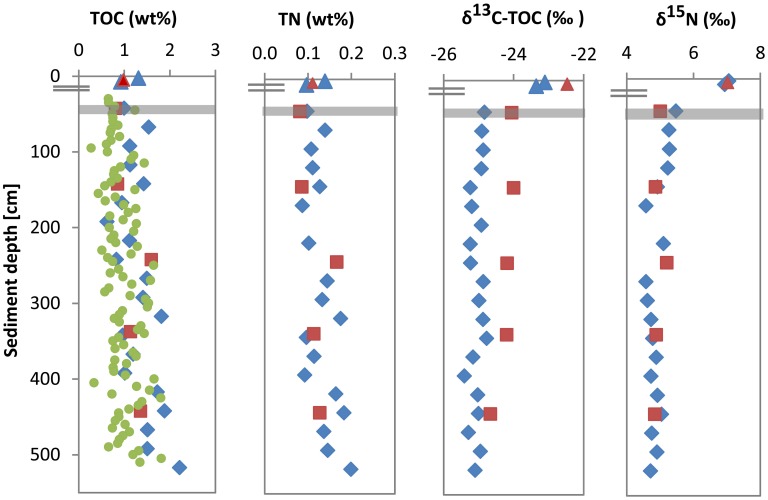
Depth profiles of TOC, TN, stable carbon, and stable nitrogen in surface and subsurface sediments of the Helgoland mud area. Surface sediment; core UT2012 (blue triangle), surface sediment; core HE421-004 (brown triangle), deep sediment; core HE376-007-5 (blue diamond), deep sediment; core HE376-007-2 (high-resolution TOC, green dots), deep sediment; core HE406-008 (brown square). Gray bar represents SMT.